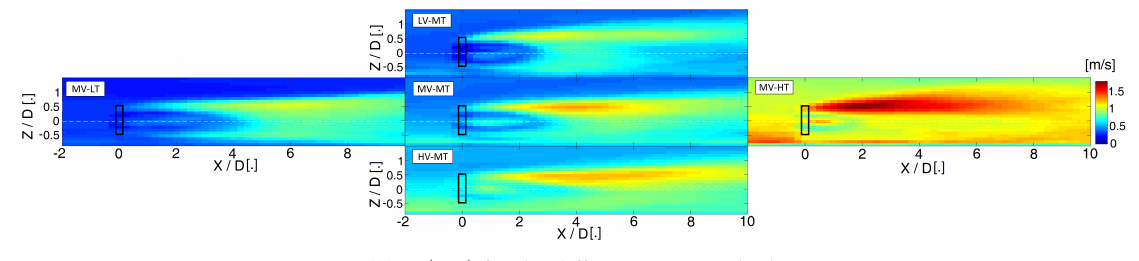
Figure 2. Flow statistics of the simulated wind turbine wakes for the five different inflow cases studied. The figures present vertical planes at Y = 0 of the longitudinal component of the wind velocity in terms of its average ( a ) and its standard deviation ( b ). The black boxes correspond to the location of the wind turbine